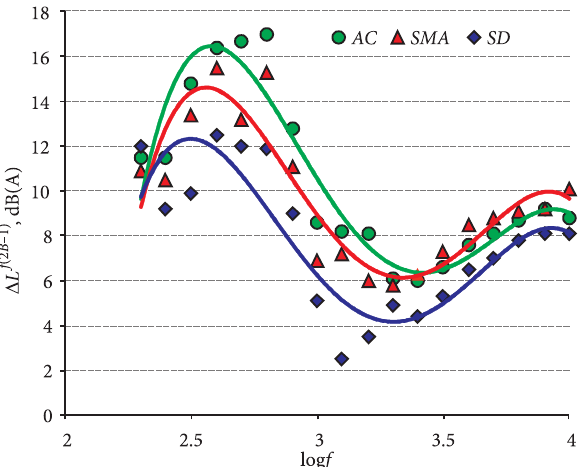
Fig. 5. Values of differences between noise levels from multiple- axle heavy vehicle and passenger car on three tested pavements